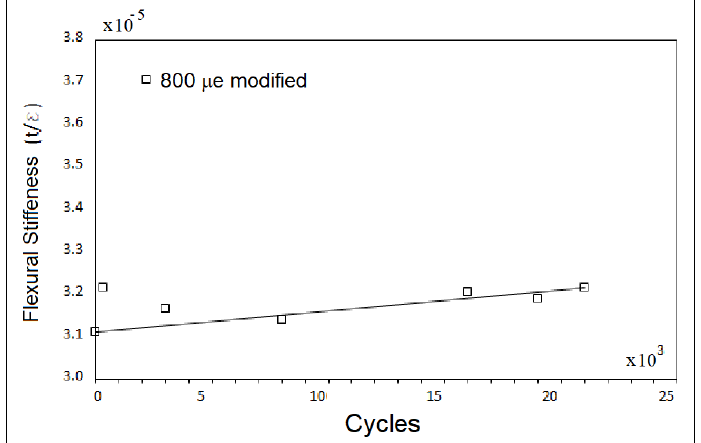
Figure 18. Evolution of flexural stiffness in modified panel F up to 0.27 × 10 5 impact cycles with P = 343 kN/m 2. Table 4. Conditions of the vertical weight drop tests on panels modified with viscoelastic layer.